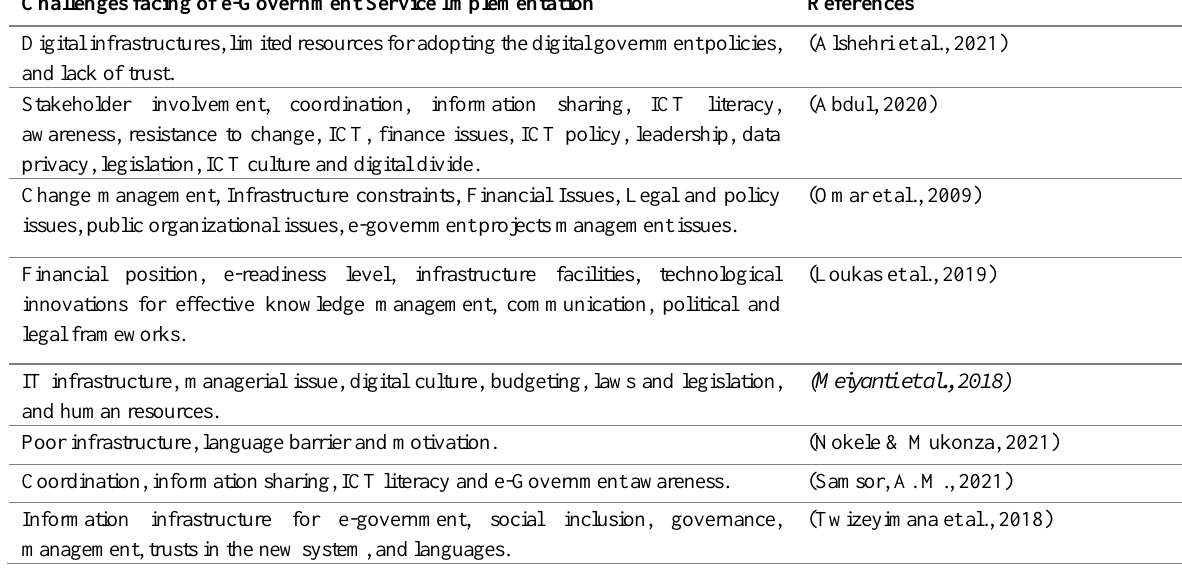
Table 1: Challenges Facing of E-Government Services